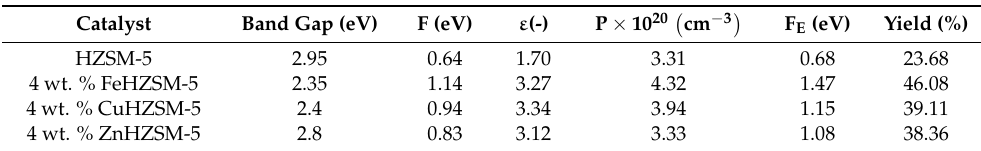
Table 5. The relation between electrical property and catalytic activity for HZSM-5, 4 wt. %